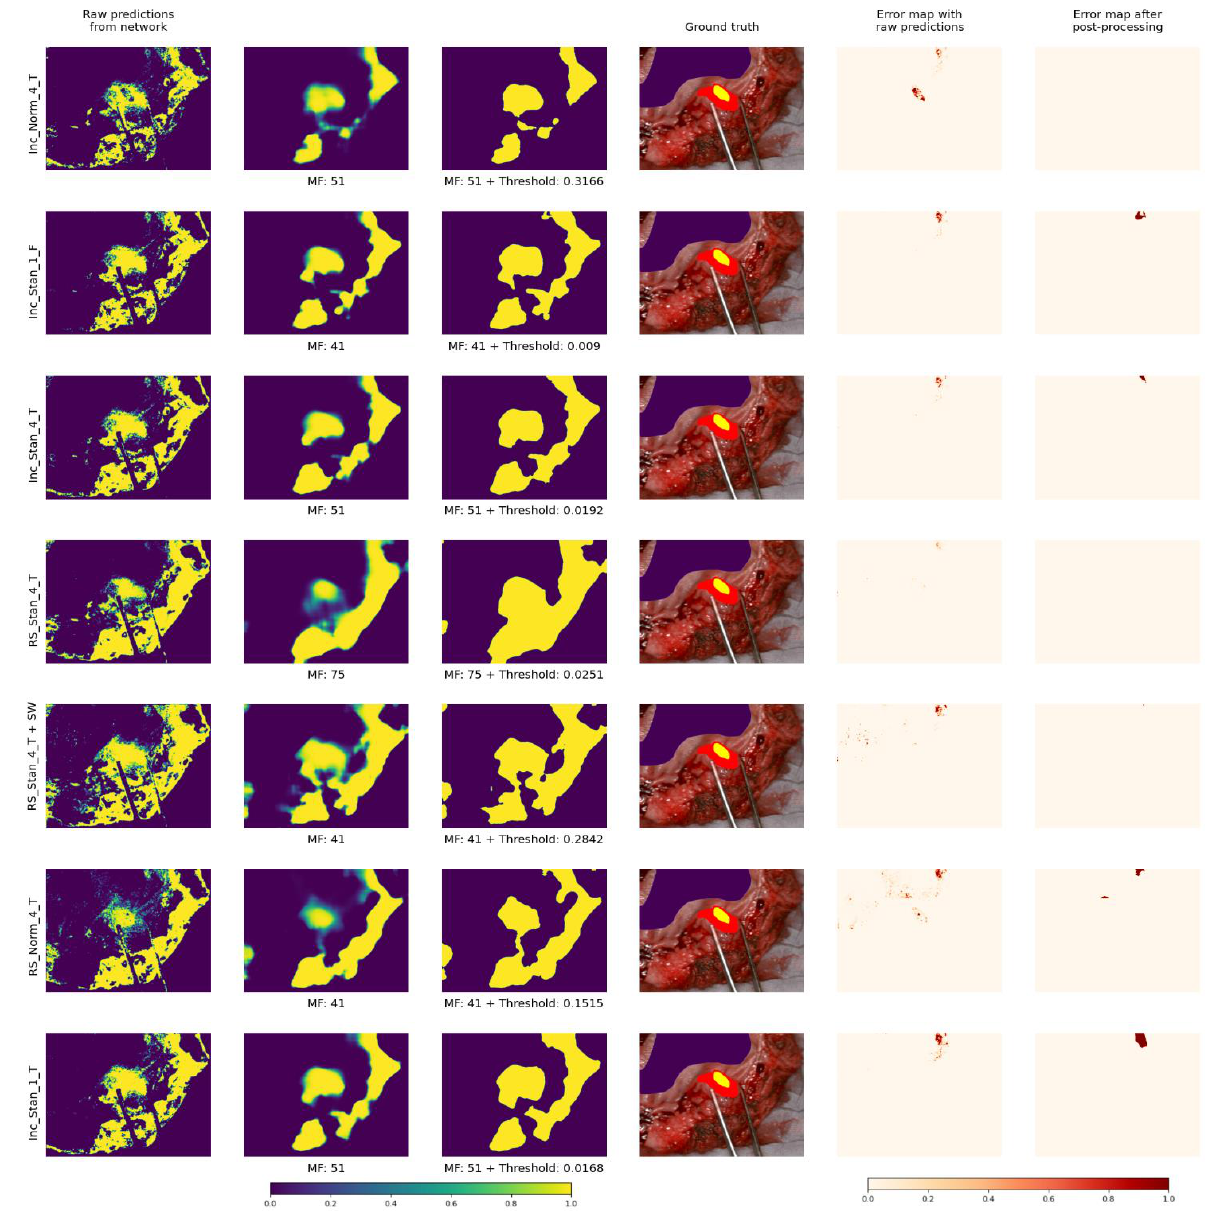
Figure 13. Visual results for one patient over all models with corresponding optimal parameters.